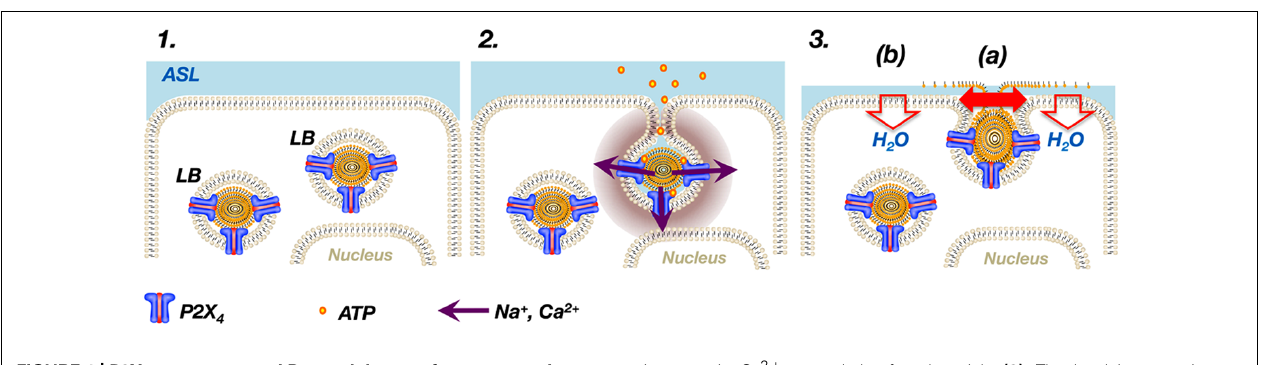
increase in Ca 2 + around the fused vesicle (2) . The local increase in Ca 2 + promotes fusion pore expansion (3a) . In addition, the inward- rectifying cation current on the apical side results in vectorial ion trans- port across ATII cells, which in turn promotes fluid resorption and thereby facilitates adsorption of newly released surfactant into the air–liquid interface (3b) . ASL = alveolar surface